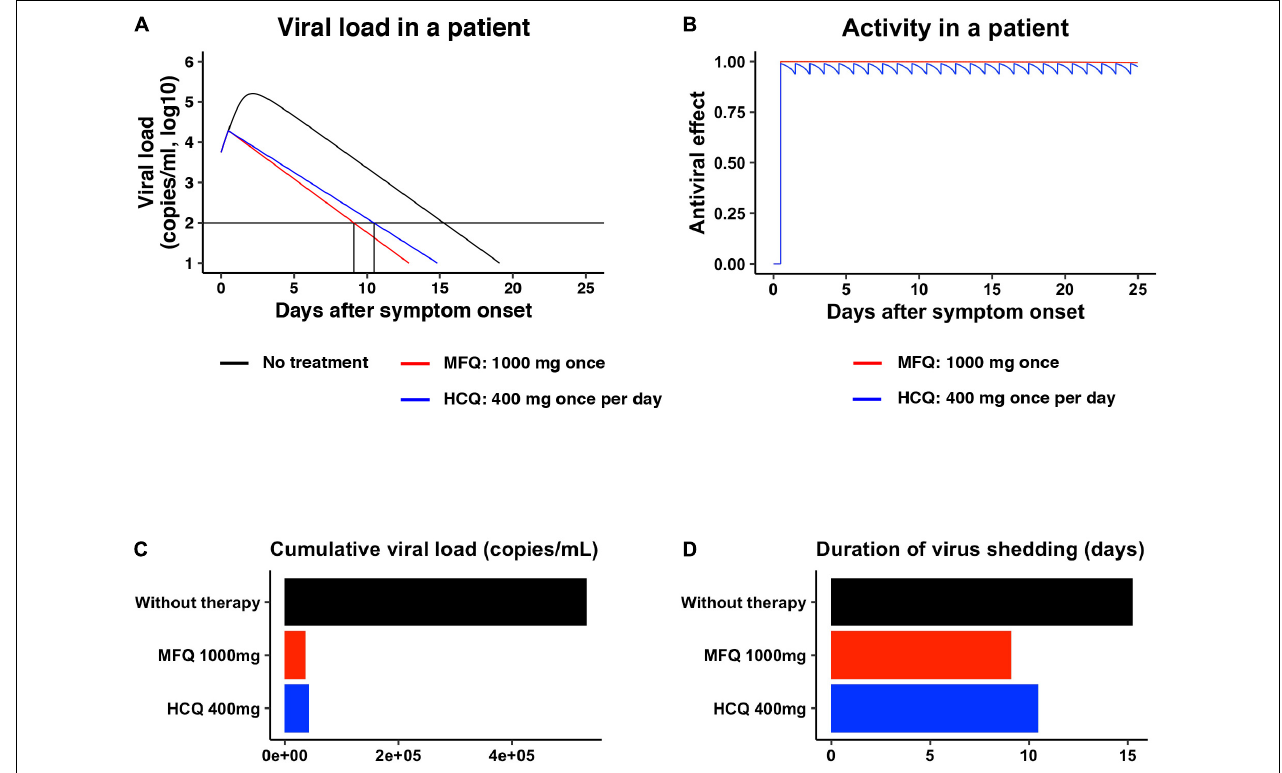
FIGURE 5 | Prediction of the impact of MFQ and HCQ treatment on SARS-CoV-2 dynamics in clinical settings. (A,B) The predicted viral load dynamics without ( A , black), upon MFQ (1,000 mg oral, once) ( A , red) or upon HCQ (400 mg oral, once per day) ( A , blue) administration and the time-dependent antiviral activity of MFQ and HCQ (B) predicted by pharmacokinetics/pharmacodynamics/viral-dynamics (PK/PD/VD) models. (C,D) The cumulative viral load calculated as the area under the curve in (A) and the duration of virus shedding (days) [time from symptom onset to the day achieving a viral load under the detection limit (black horizontal line)